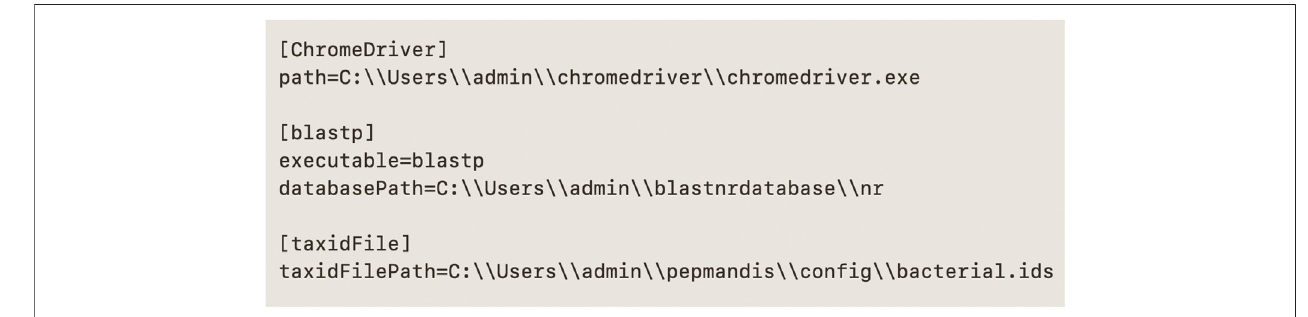
FIGURE 5 | Example of a configuration fi le for Windows Operating System. Section headers are followed by keys and their actual values (the values represent the absolute paths to the various external fi les and/or executables).